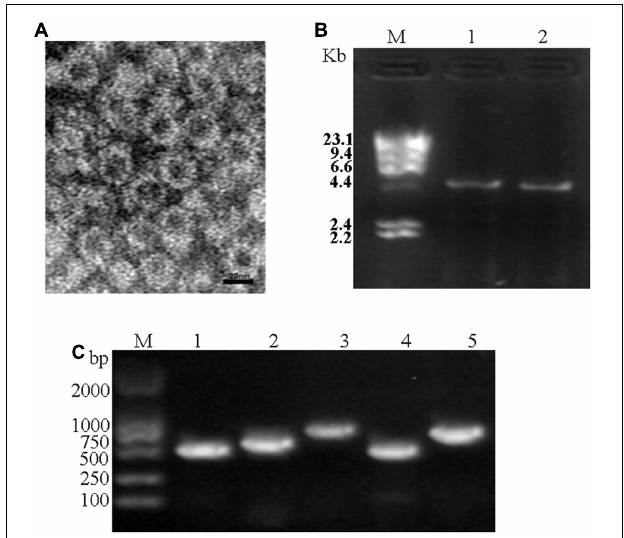
FIGURE 7 | Electron microscopy and RT-PCR. (A) Viral particles purified from field-collected P. striiformis urediniospores. (B) Agarose gel electrophoresis of dsRNAs extracted from purified virus particles of PsVs (lane 1) and the urediospores of P. striiformis from field-collected samples (lane 2). (C) Confirmation of identity of dsRNAs extracted from purified virus particles using PsVs 1 − 4 specific primers (lanes 1 − 4, respectively) (Supplementary Table S1). M indicates molecular markers of λ DNA digested with Hind III. PsVs (1 to 4), ranging from 5,008 to 5,061 nt, were all